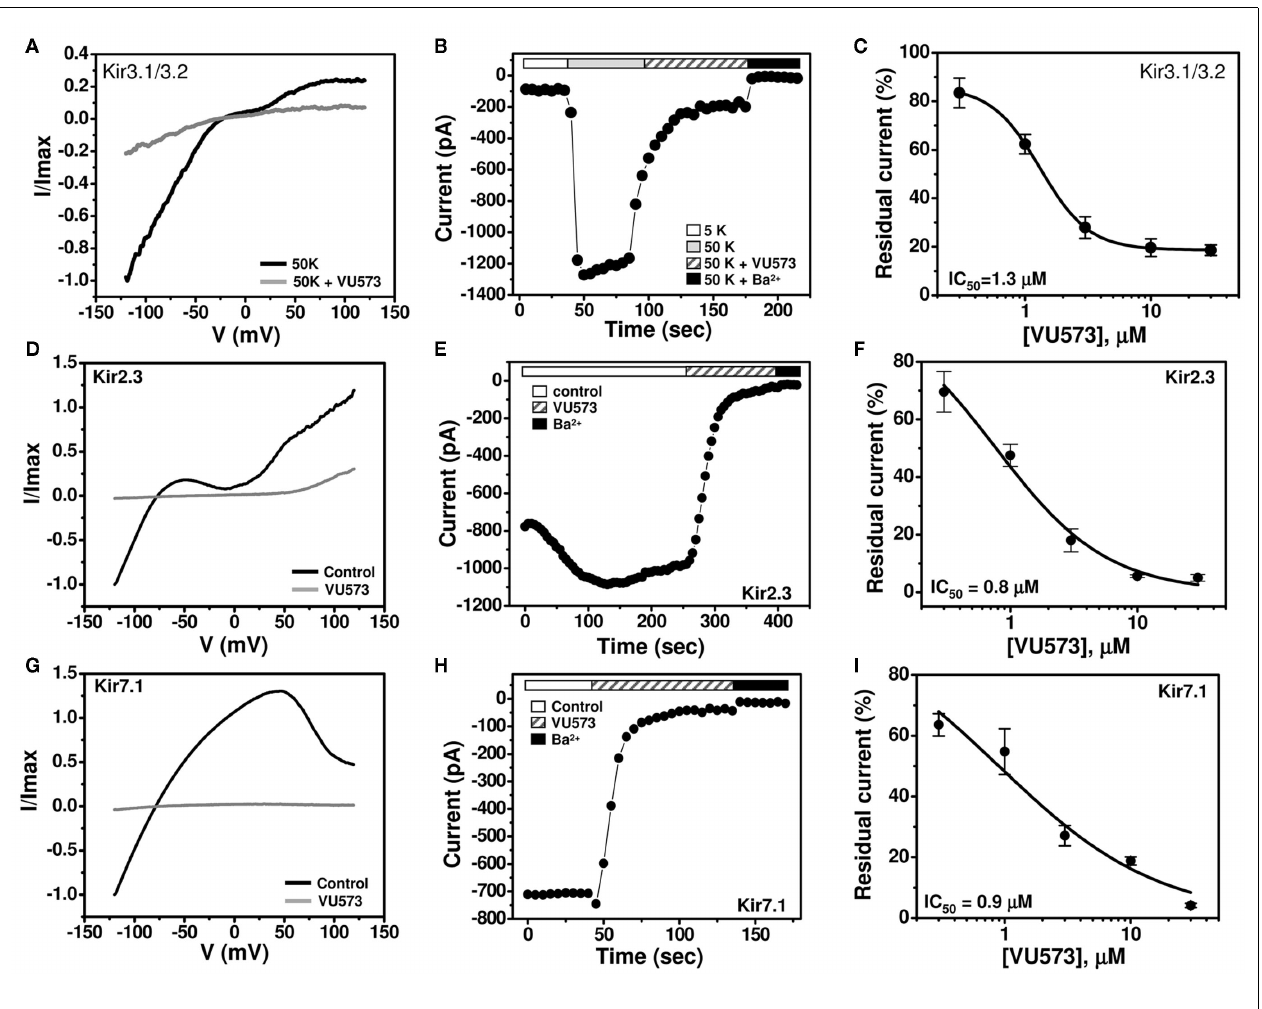
are shown. (B,E,H) Representative time course traces of VU573-dependent inhibition of Kir3.1/3.2, Kir2.3, and Kir7.1 by 30 μ M VU573 using the protocol described above. After achieving whole-cell access, the current was allowed to stabilize before adding 30 μ MVU573 and then 2mM barium (Ba 2 + ) to inhibit channel activity. (C,F,I) Mean ± SEM concentration–response curves for Kir3.1/3.2 ( n = 4–7), Kir2.3 ( n = 4–6), and Kir7.1 ( n = 4–7),